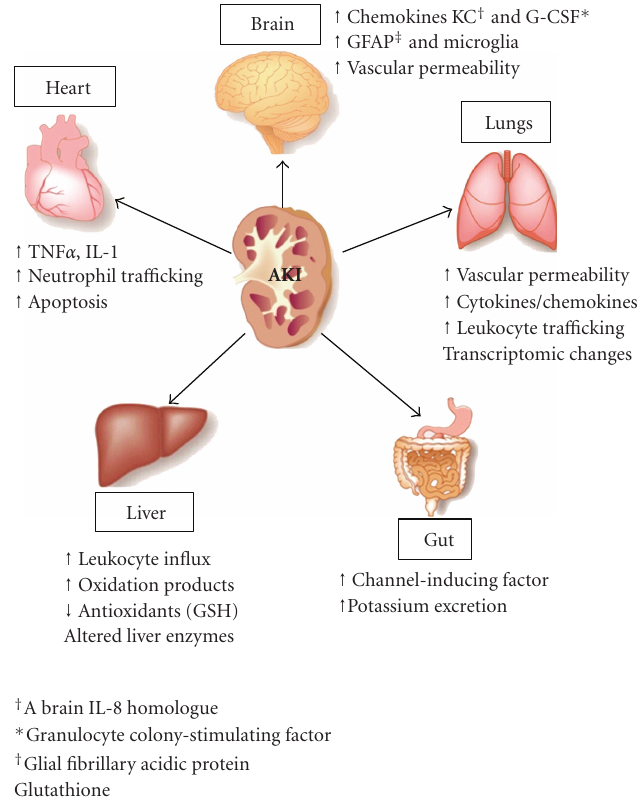
Figure 1: AKI and organ crosstalk . AKI induces remote organ injury in the heart, brain, lungs, liver, and gut involving multiple inflammatory pathways, including increased expression of soluble proinflammatory mediators, innate and adaptive immunity, cellular apoptosis, physio- logic derangements and genomic